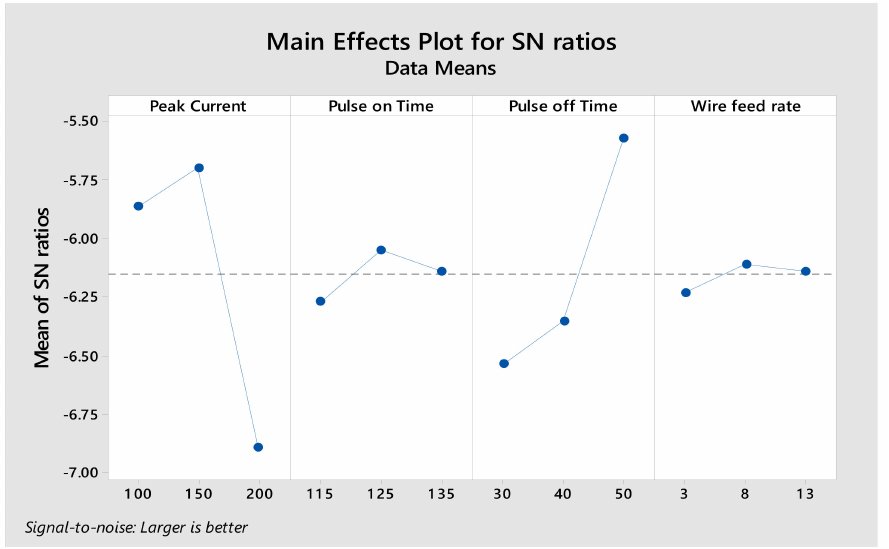
Figure 12. Main effects plot for C i .